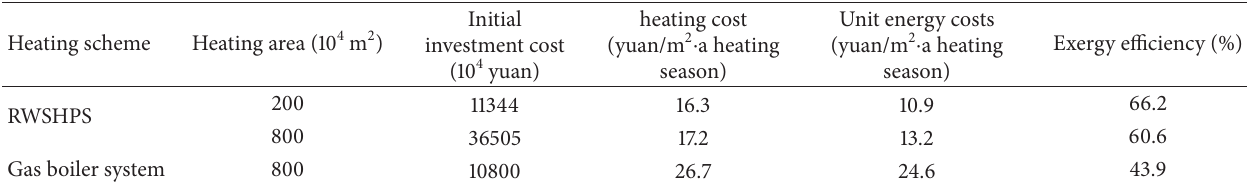
Table 4: Comparison of the two heating